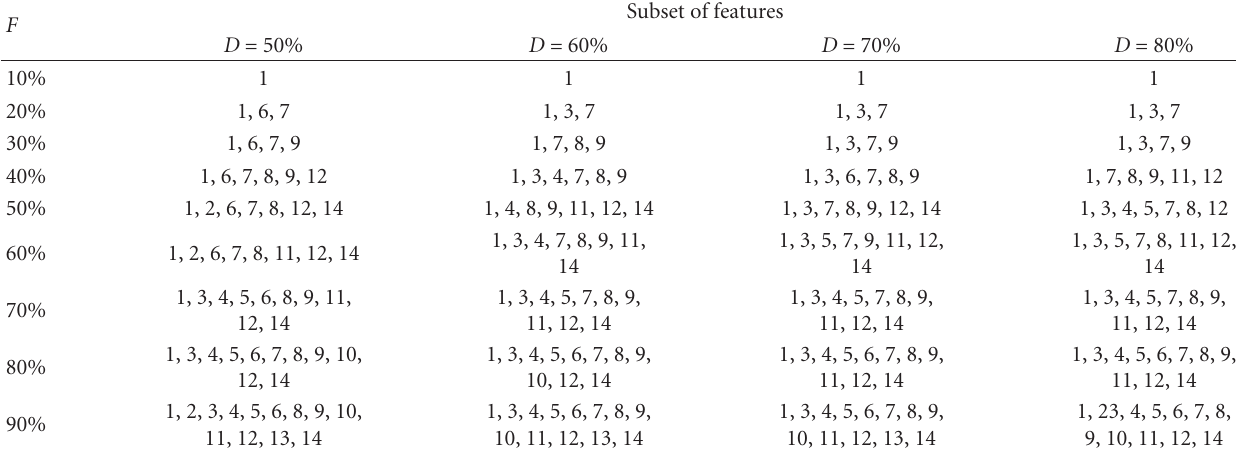
Table 9: Best subsets of features for body fat data.